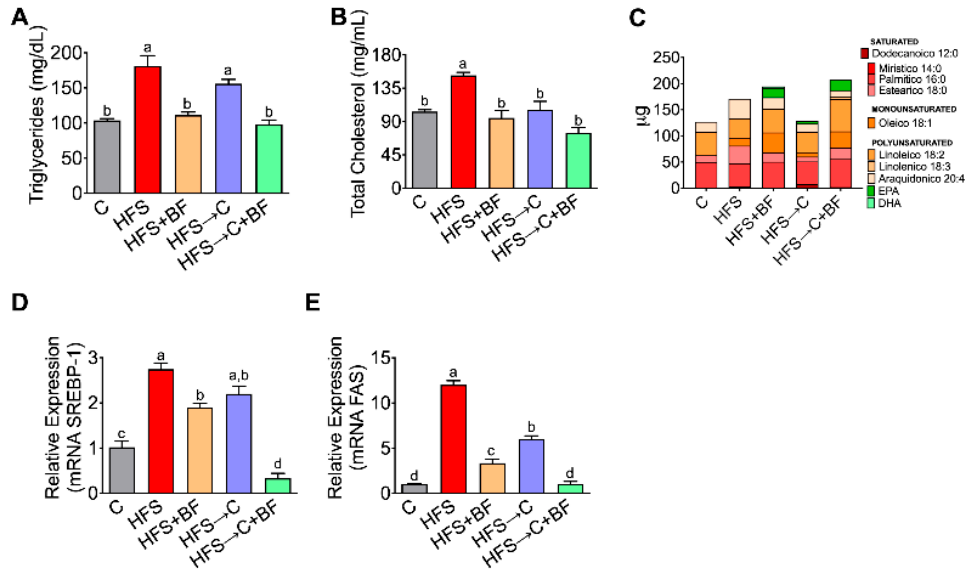
Figure 6. Consumption of bioactive foods decreased lipogenesis and improved lipid serum profile. ( A ) Serum triglycerides, ( B ) Serum total cholesterol, ( C ) Fatty acids serum profile, relative hepatic expression by ( D ) SREBP-1, and ( E ) FAS in rats fed control (C) or high fat diet + 5% sucrose (HFS) with or without bioactive foods. Data are expressed as the mean ± SD. Mean values with different letters show statistical differences between each other. Data were analyzed by one-way ANOVA followed by Tukey post-hoc test. Results were considered statistically significant at p < 0.05.